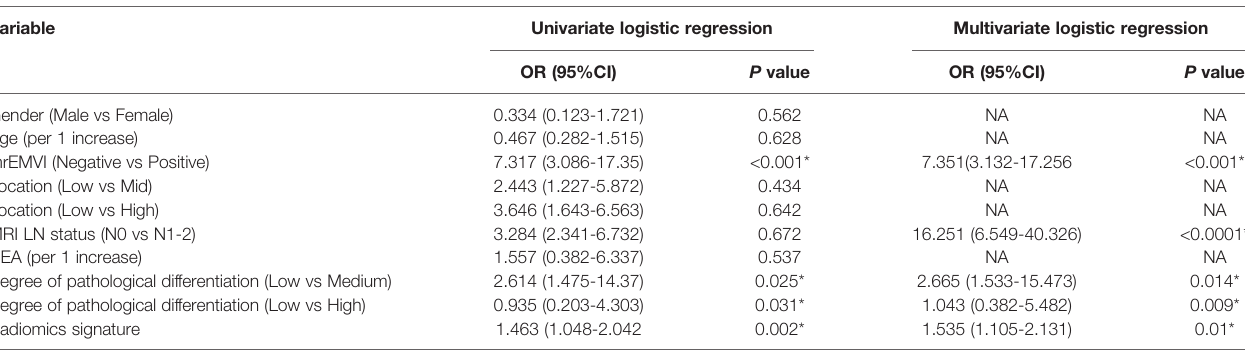
TABLE 3 | Stepwise logistic regression analysis of EMVI prediction.